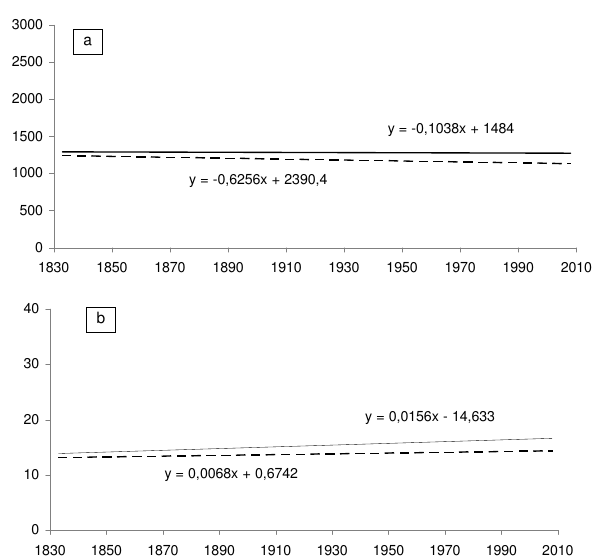
Fig. 8. Annual rainfall trend at Genoa (bold lines) and Chiavari (dashed lines): (a) height (mm), (b) precipitation rate (mmdays − 1